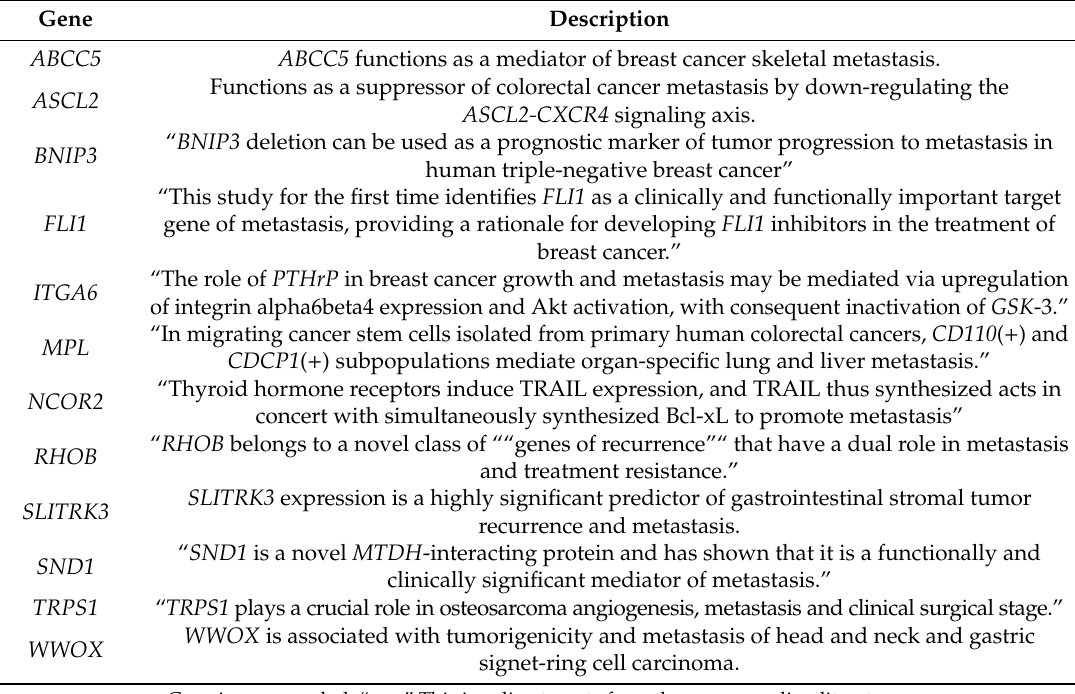
Table 2. Known metastasis-associated genes and their descriptions in